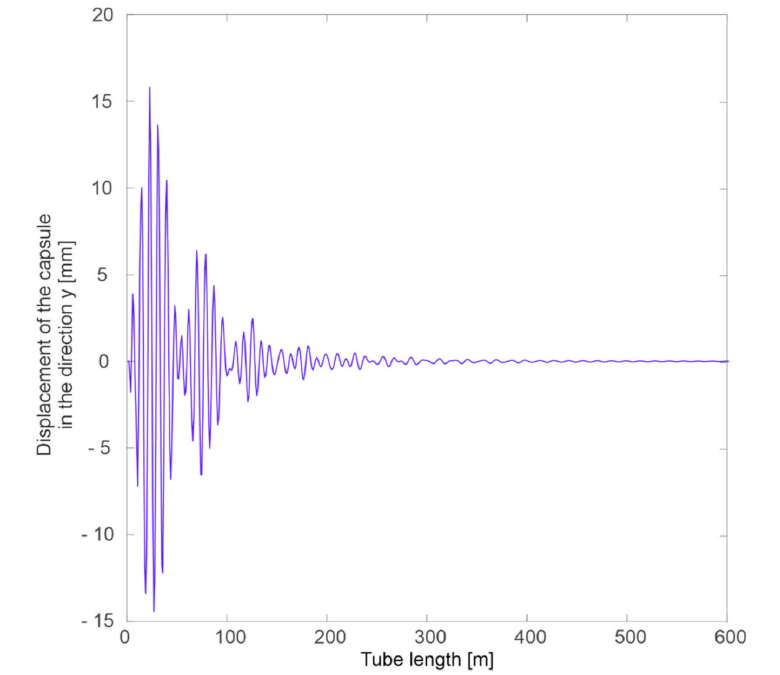
Figure 16. Vertical displacement in direction y of the capsule at a speed of 1000 km / h.